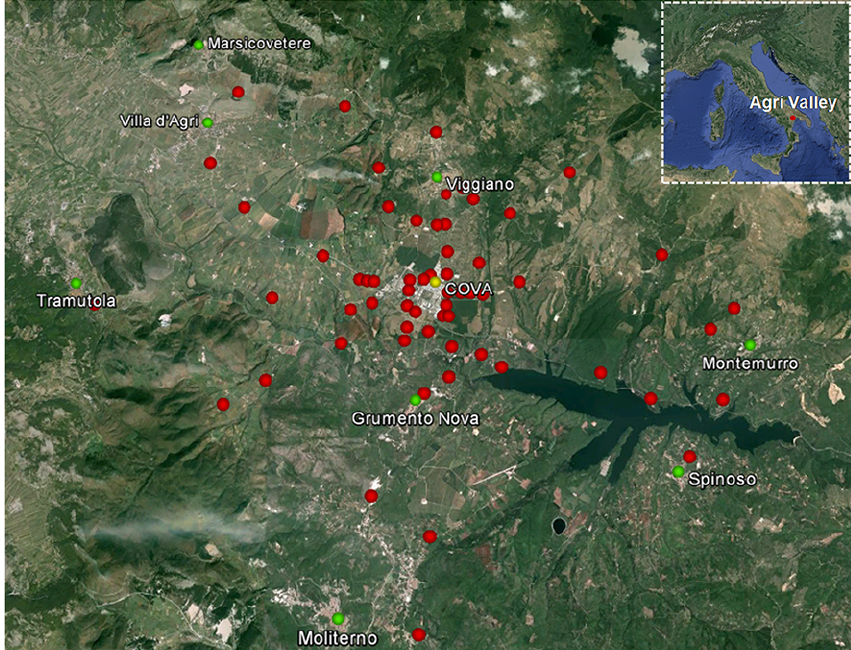
Figure 1. Location of the biomonitoring stations (red placemarks). The image also reports the location of the Centro Olio Val d’Agri (COVA) plant (yellow placemark) and of the main towns (green placemarks). Aerial photography to courtesy of Google Earth (http://earth.google.